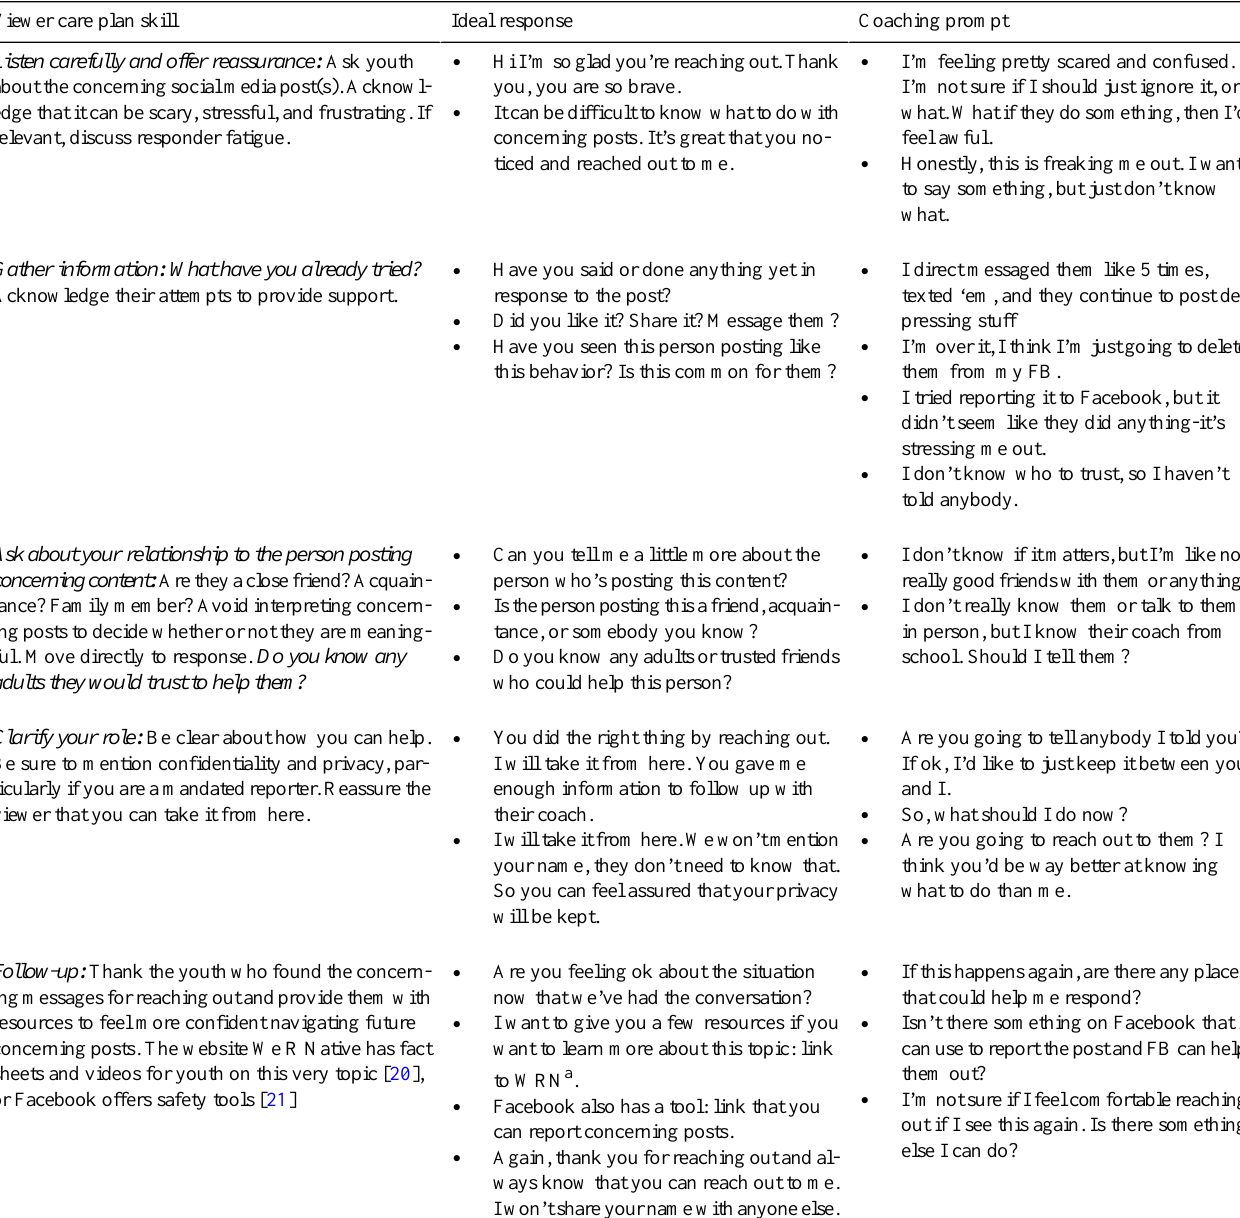
Table 1. Ideal responses and coaching prompts provided during the role-play